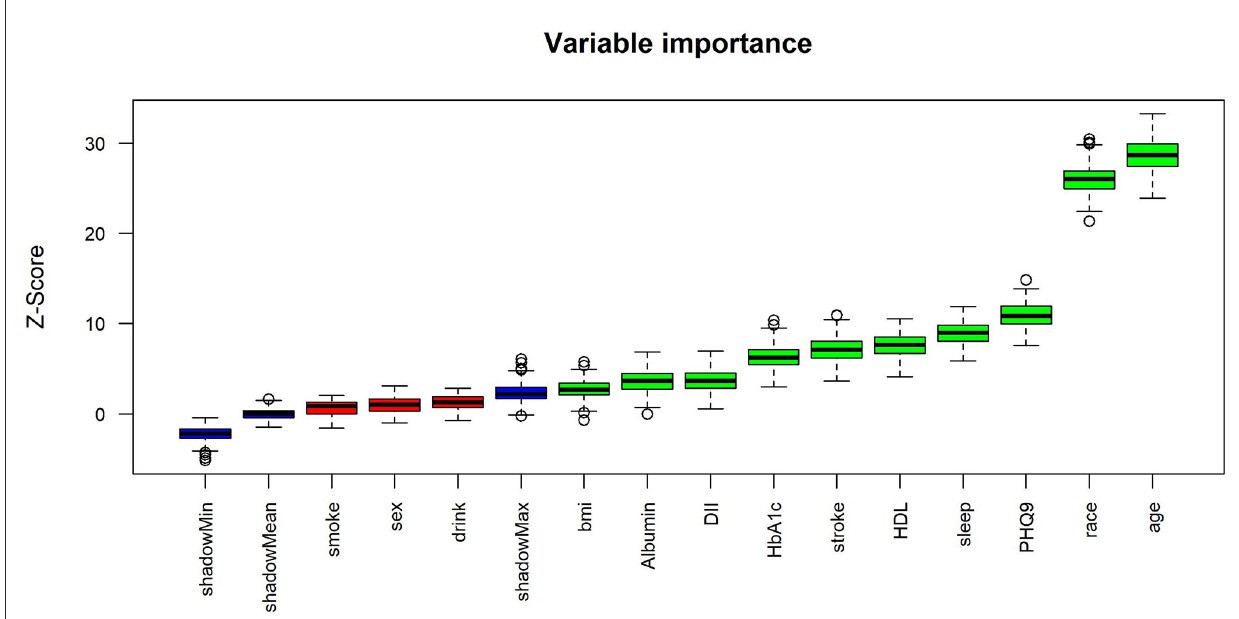
FIGURE2 Feature selection based on the Boruta algorithm. bmi, Body mass index; drink, Had at least 12 alcohol drinks/year; smoke, Smoke at least 100 cigarettes in life; stroke, ever told you had a stroke; DII, Dietary Inflammatory Index; HbA1c, glycated hemoglobin; PHQ9, Patient Health Questionnaire-9; sleep, how much sleep do you get.